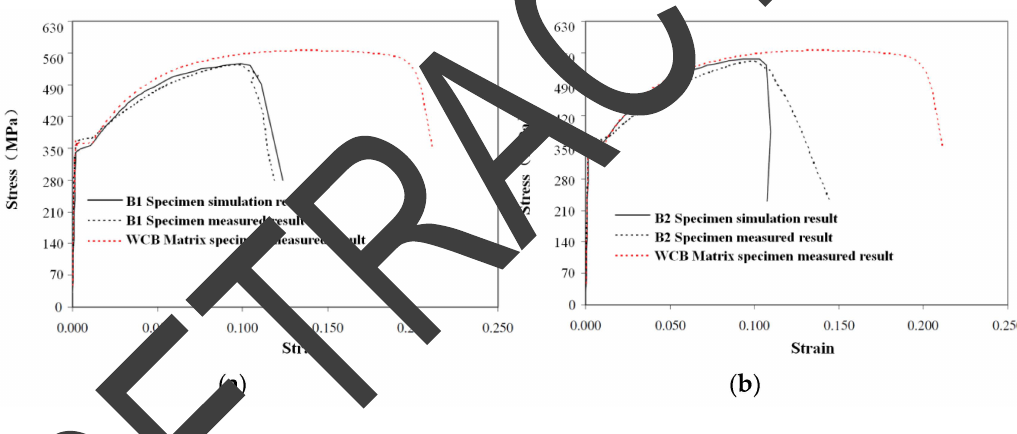
Figure 8. Tensile result comparisons of the defect-containing specimens between test and simulation: ( a ) Specimen B1; ( b ) Specimen B2.